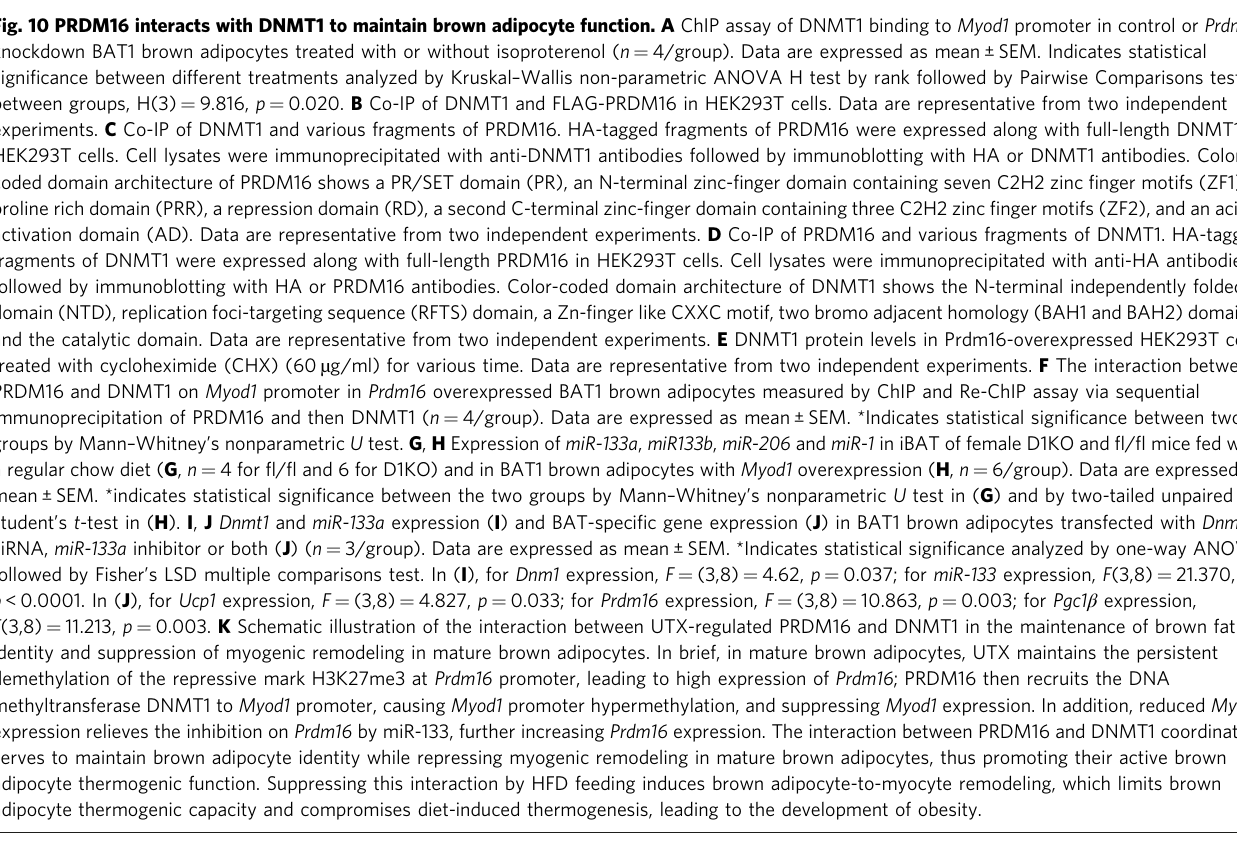
Fig. 10 PRDM16 interacts with DNMT1 to maintain brown adipocyte function. A ChIP assay of DNMT1 binding to Myod1 promoter in control or Prdm16 knockdown BAT1 brown adipocytes treated with or without isoproterenol ( n = 4/group). Data are expressed as mean ± SEM. Indicates statistical signi fi cance between different treatments analyzed by Kruskal – Wallis non-parametric ANOVA H test by rank followed by Pairwise Comparisons test between groups, H(3) = 9.816, p = 0.020. B Co-IP of DNMT1 and FLAG-PRDM16 in HEK293T cells. Data are representative from two